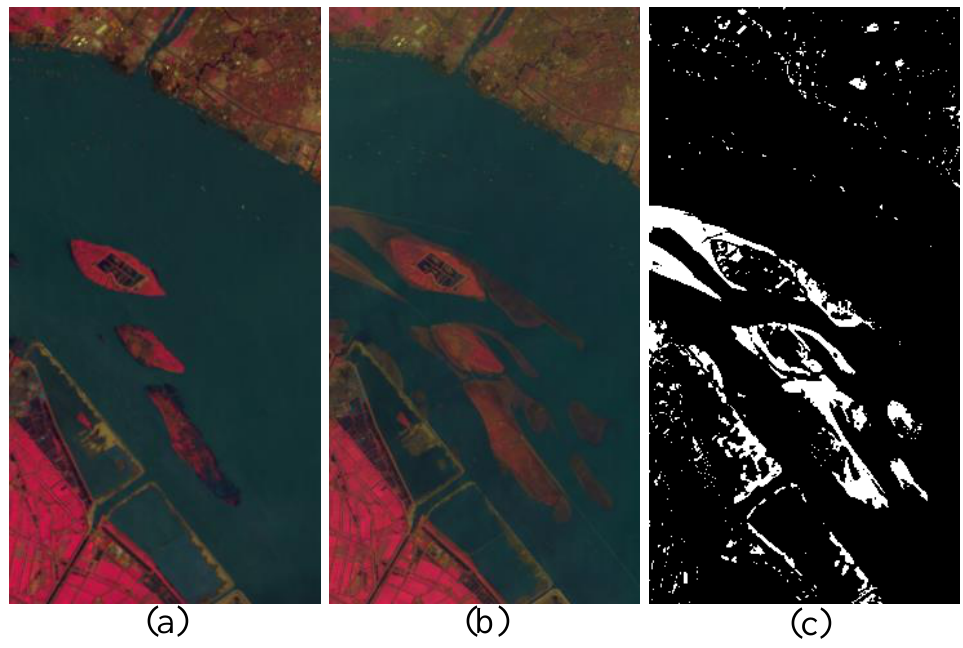
Figure 4. River dataset: ( a ) T 1 -time image, ( b ) T 2 -time image, and ( c ) reference image. (Notation: white color and black color denote changed pixels and unchanged pixels,